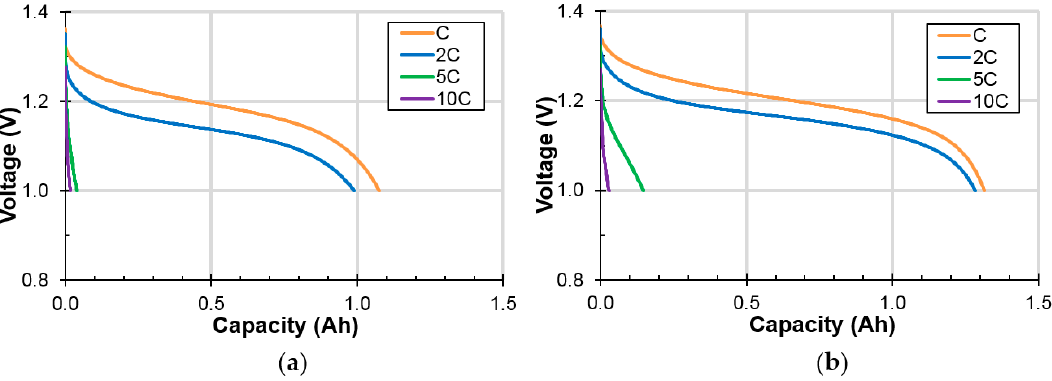
Figure 6. Discharge voltage profiles at different discharge rates of ( a ) cell A, and ( b ) cell B measured at − 10 °C.